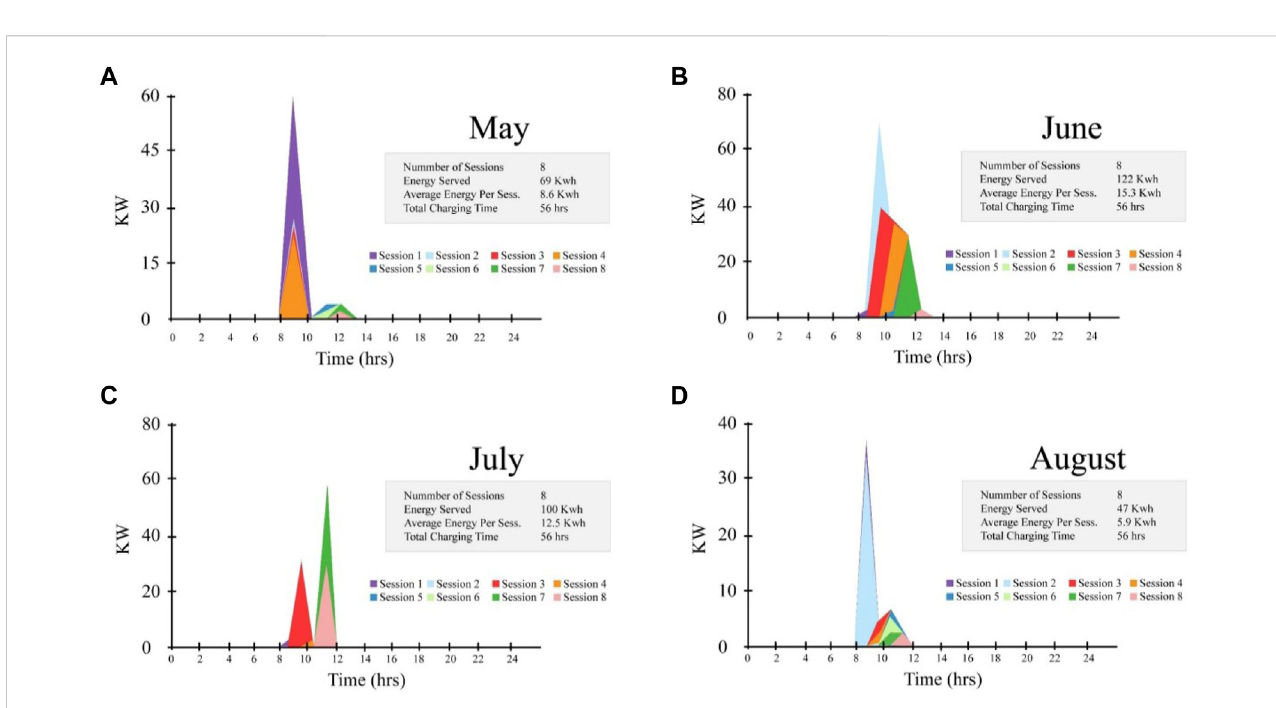
FIGURE 8 Energy scheduling (A) May, (B) June, (C) July and (D)